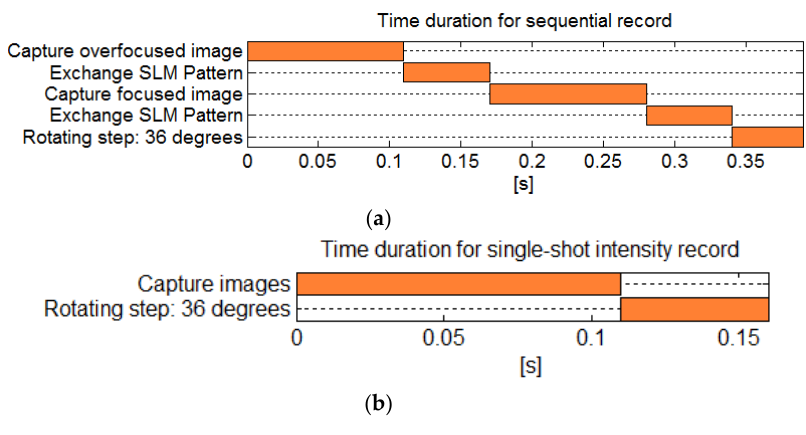
Figure 14. Time duration for tomographic recording process of the diamond object in ( a ) the sequential setup and ( b ) the single-shot setup.